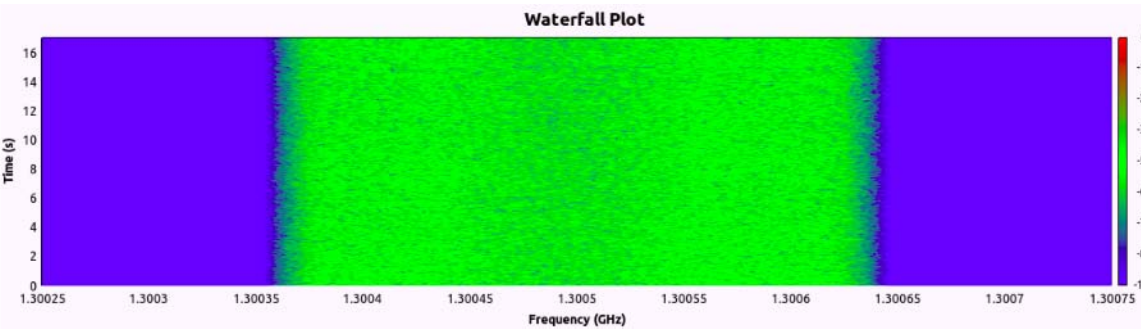
Figure 9. Sensing results according time at